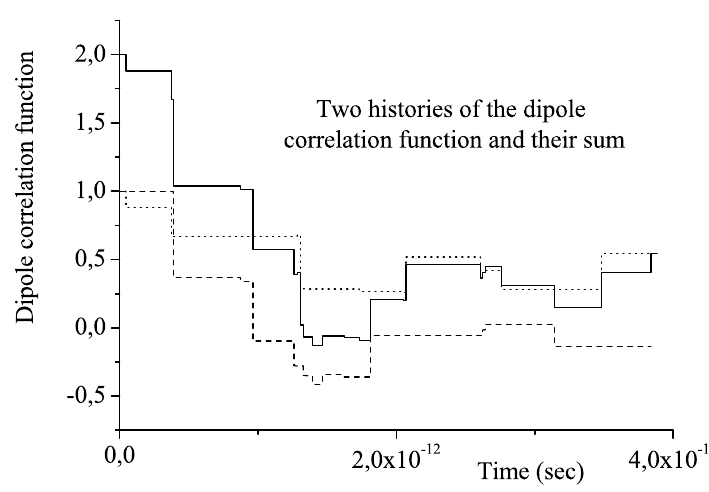
Fig. 1. Modulus of the electric (cid:12)eld created by a stepwise constant stochastic